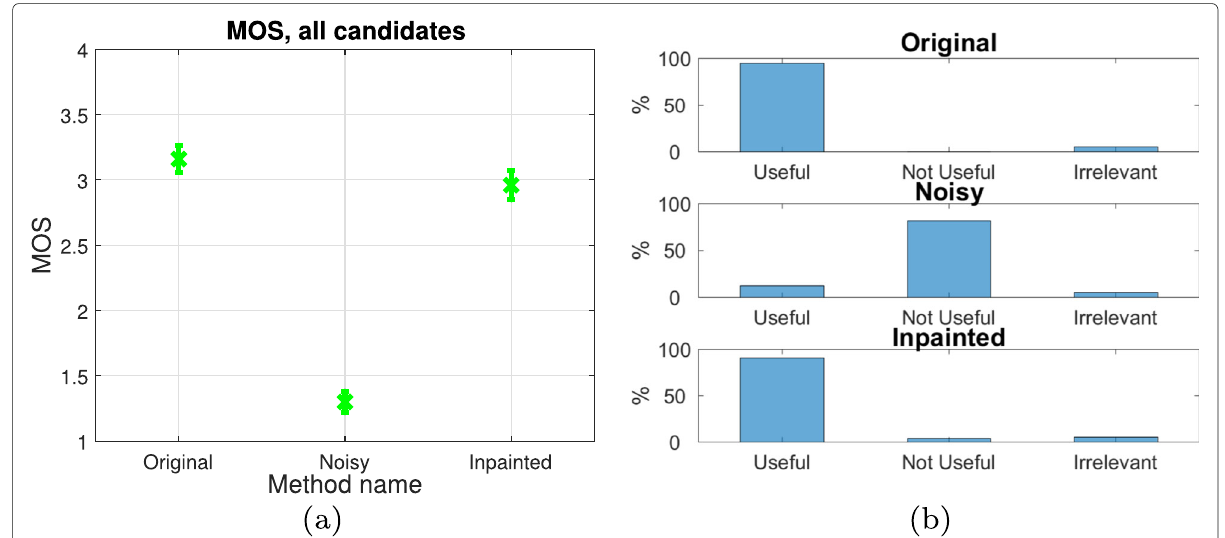
Fig. 11 Results from subjective test for all candidates. a MOS score (4 refers to highest quality). b Histogram showing usefulness of images